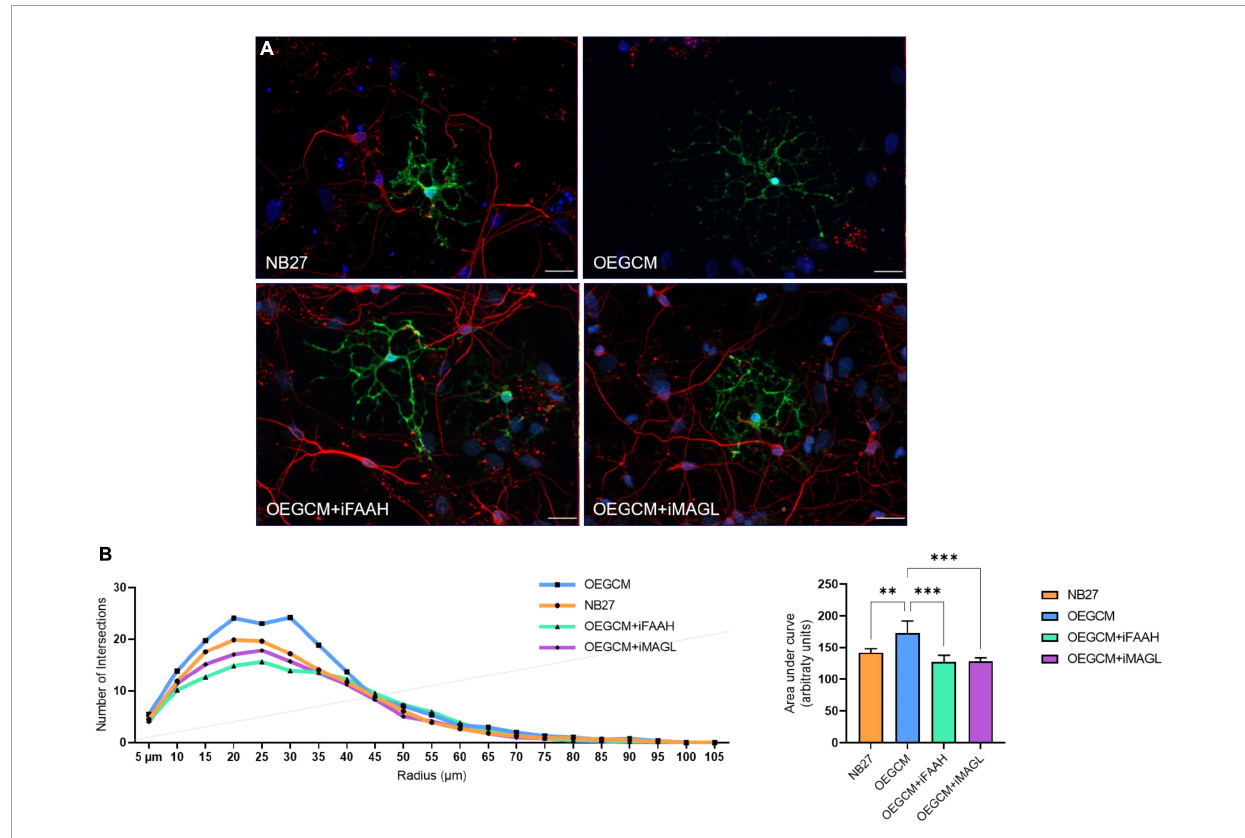
FIGURE9 OEGCM from cultures treated with FAAH or MAGL inhibitors decreases the complexity of mature oligodendrocytes process branching. In panel (A) , representative immunocytochemistry of MBP-positive cells showed in green, neurons stained with TUJ-1 in red and cell nuclei shown in blue (DAPI). Magnification of 40x, scale bar: 20 µ m. In panel (B) , the area under the curve calculates the number of intersections in every 0.5 µ m radium in each Sholl circle. Data is presented as mean ± SD, statistical analysis of AUC was performed using One-way ANOVA and Tukey’s as post hoc test. NB27: N = 5, OEGCM: N = 3, OEGCM + iFAAH: N = 5, OEGCM + iMAGL: N = 4; p = 0.0061 for NB27 vs. OEGCM, p = 0.2070 for NB27 vs. OEGCM + iFAAH, p = 0.2750 for NB27 vs. OEGCM + iMAGL, p = 0.0003 for OEGCM vs. OEGCM + iFAAH, p = 0.0005 for OEGCM vs. OEGCM + iMAGL. ** p < 0.01 and *** p <